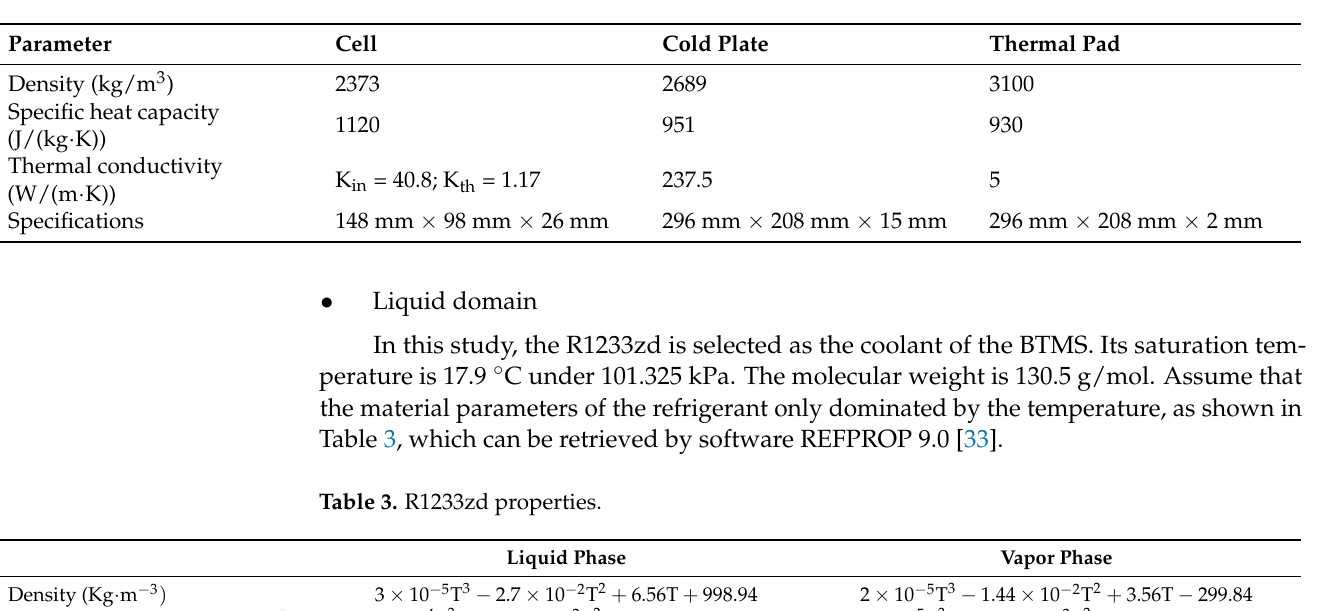
Table 2. Structure and material parameters.